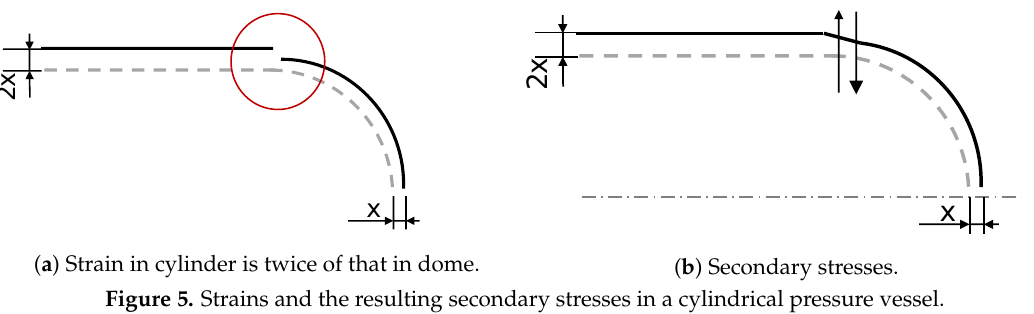
Figure 5. Strains and the resulting secondary stresses in a cylindrical pressure